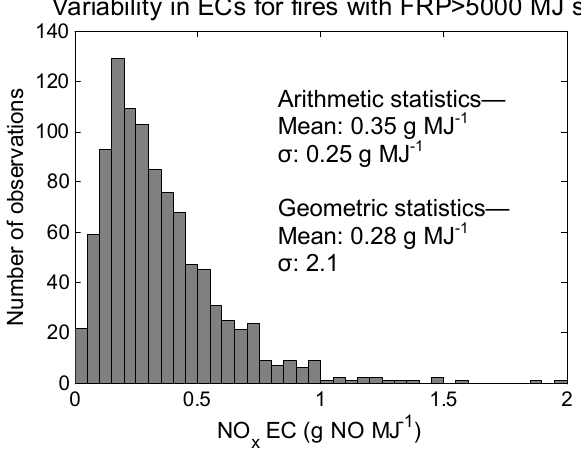
Fig. 2. Histogram of ECs of NO x (as NO) measured for fires with FRP above 5000MJs − 1 . ECs were calculated by dividing the MER by FRP for individual